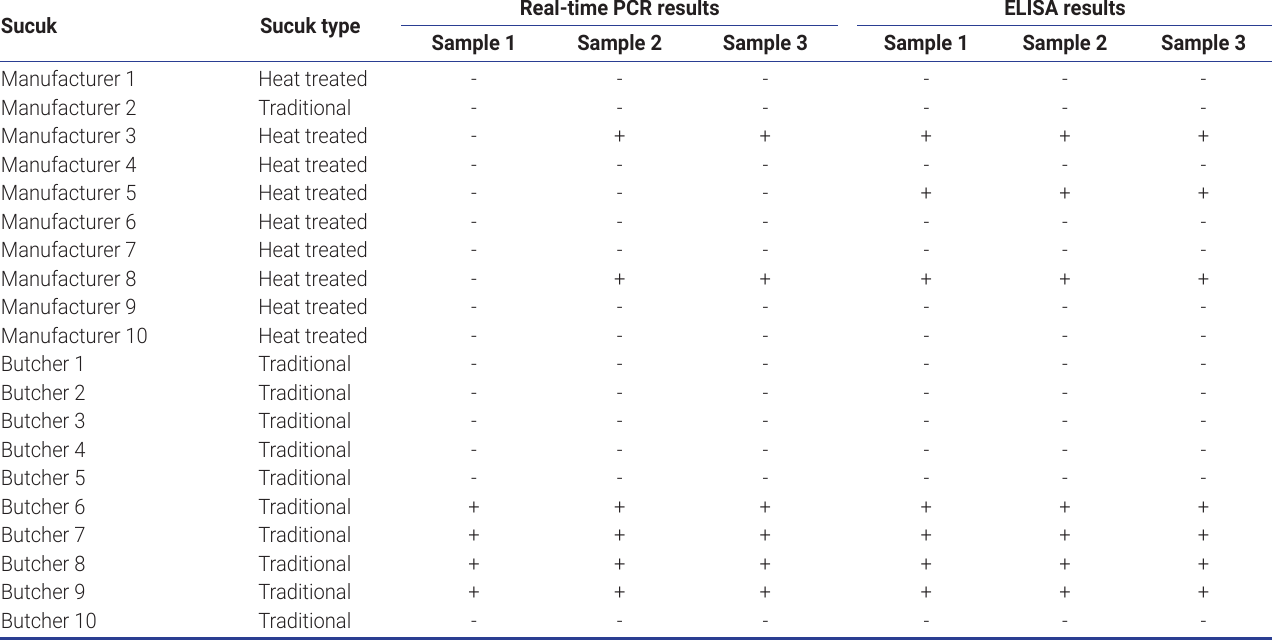
Table 1. Real-time PCR and ELISA results of a total of 60 sucuk samples